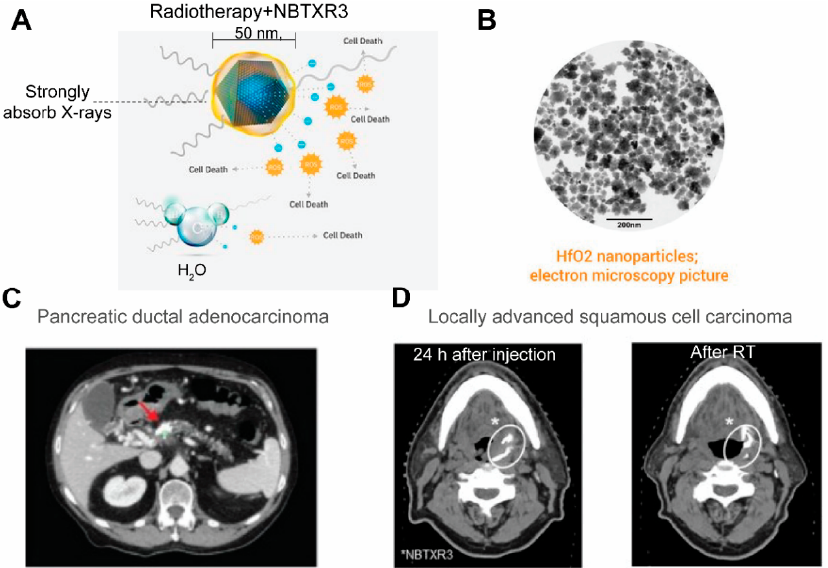
Figure 7. NBTXR3 as radioenhancers that are trackable by CT. ( A ) An illustration of the compo- sition of NBTXR3 and its radioenhancing function. NBTXR3 consists of the HfO2 crystalline core (blue) and phosphate coating (yellow). Upon ionizing radiation, HfO2 induces the generation of a substantial amount of electrons that create more energy deposition in tumor than water molecules, hence promoting cancer cell death. Source: twitter@Nanobiotix. ( B ) Electron microscopy image of NBTXR3. Source: https://www.sharepitch.com/healthcare/archives/05-2018, accessed on 22 April 2022. ( C ) Radiopaque NBTXR3 visualized on simulation CT image of a patient with pancreatic ductal adenocarcinoma (red arrow: tumor). Adapted based on Ref. [165]. ( D ) CT scans showing intratumoral localisation of NBTXR3 at 24 h after injection and after radiotherapy (RT) in a patient with locally advanced squamous cell carcinoma. *: position of NBTXR3 accumulation.Adapted based on Ref.